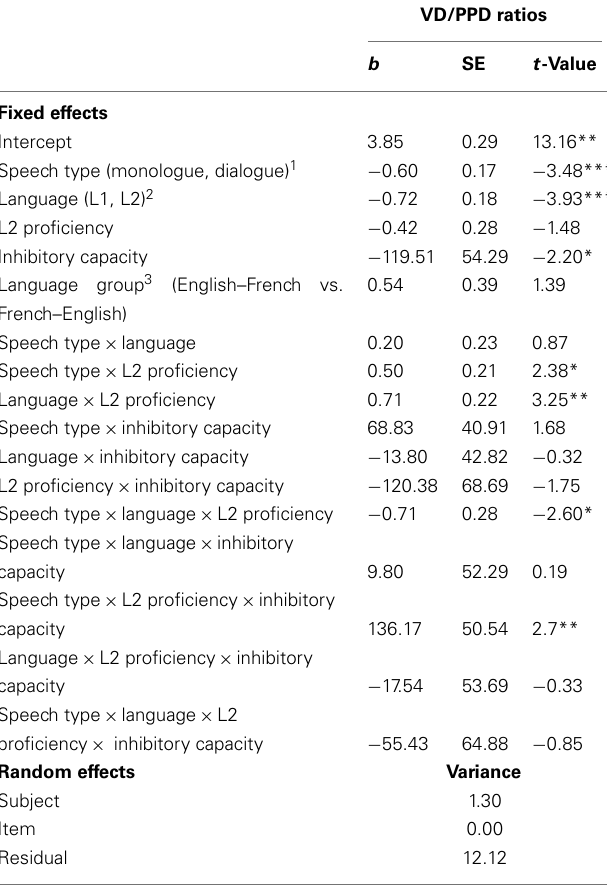
Table 6 | Linear mixed effects models for the temporal